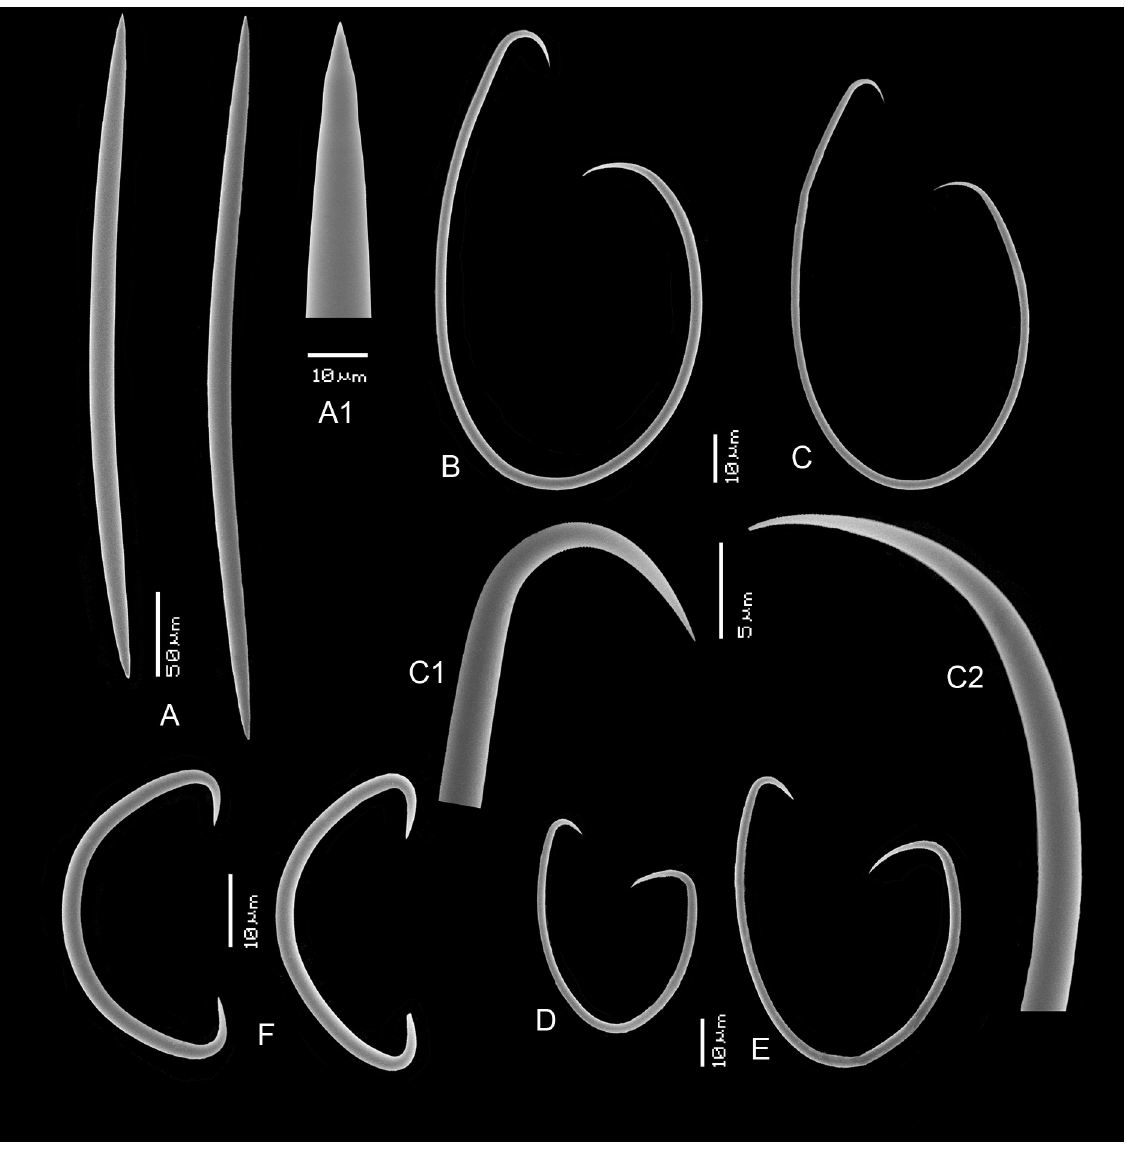
Fig. 11. Haliclona ( Flagellia ) flagellifera (Ridley & Dendy, 1886) subgen. et comb. nov., holotype, fragment of BMNH 1887.5.2.252, from Marion Island, South Indian Ocean, SEM images of the spicules. A . Oxea. A . Detail of one of the apices. B–C . Large category of flagellosigmas (I). C 1 of long ending of large flagellosigma. C . Detail of short ending of large flagellosigma. D–E . Small 2 flagellosigmas (II). F .